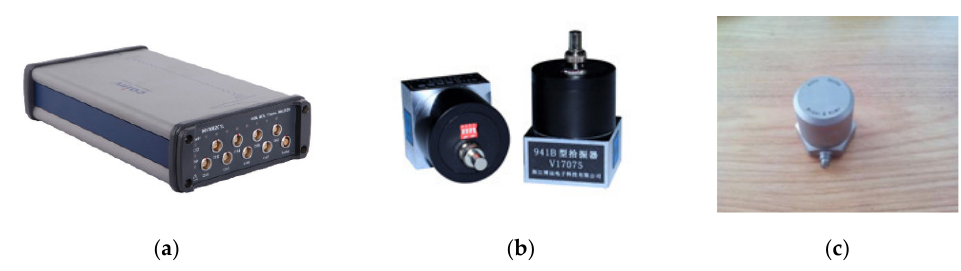
Figure 6. ( a ) INV3062C1 data acquisition; ( b ) Pickup 914B; ( c ) B&K8344 accelerometer.